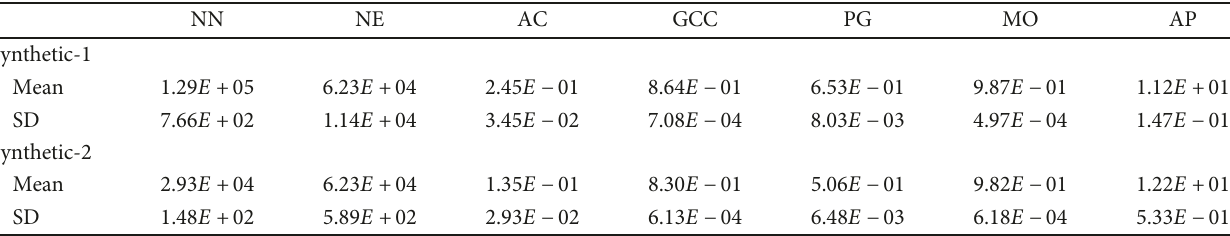
Table 4: The means and standard deviations (SDs) of speci fi c